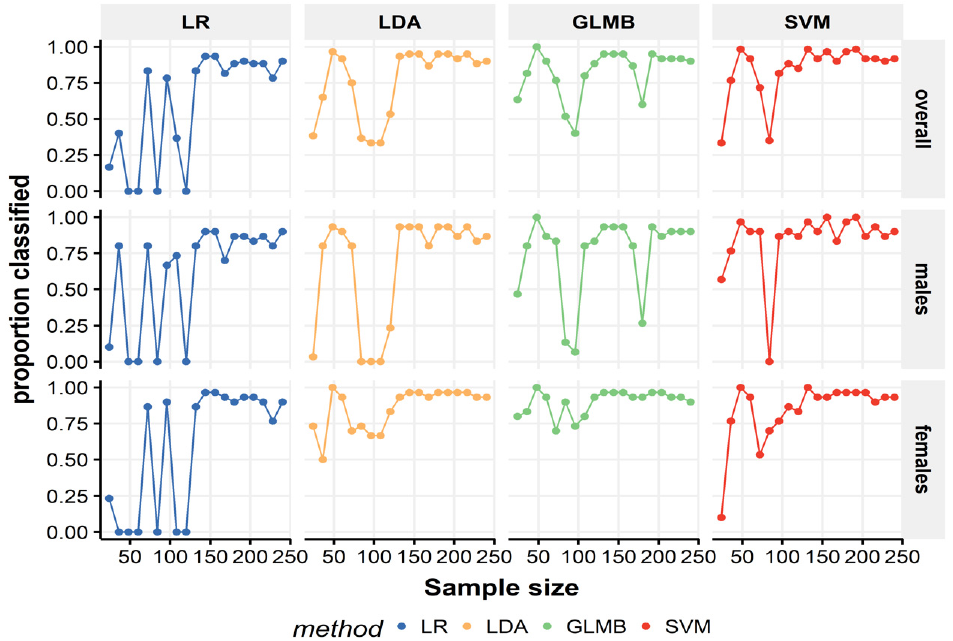
Figure 2. Influence of the training sample size on the proportion of classified specimens in the testing sample. Several sample sizes of the training dataset are plotted against the proportion of classified individuals (overall and sex specific rates) in the test dataset ( n = 60) using different ML models; each algorithm has its own panel.